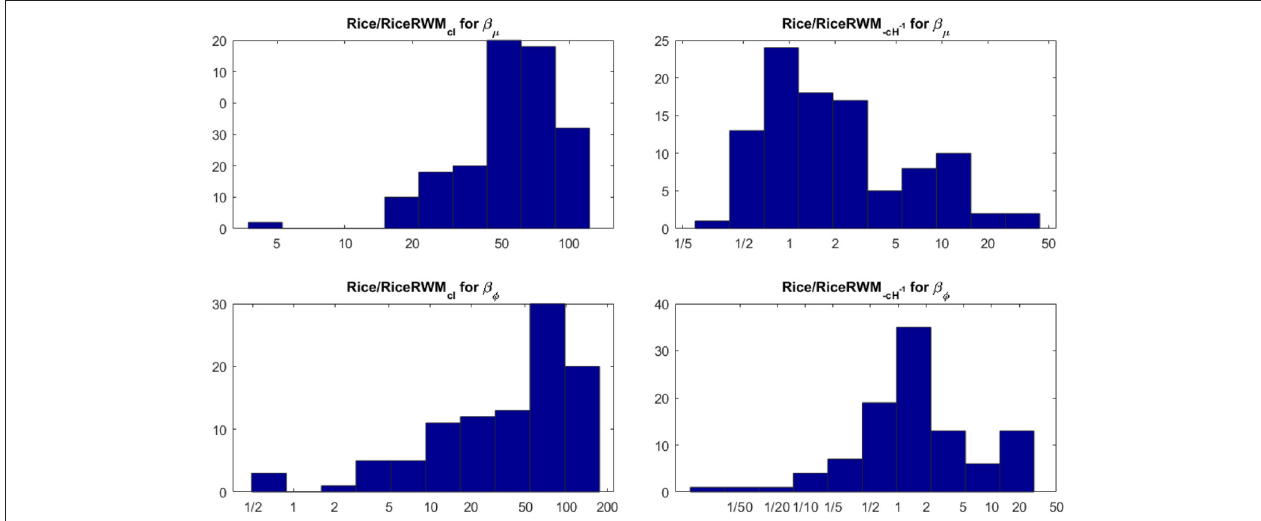
FIGURE 7 | Histograms of the ratio of independent draws per minute for our MCMC algorithm compared to each type of RWM algorithm for 100 randomly sampled white matter voxels for the Rician model. The number of independent MCMC draws is defined as the number of total MCMC draws divided by the estimated ∞ inefficiency factor IF = 1 + 2 k = 1 ρ k , where ρ k is the autocorrelation function of lag k of the MCMC chain. The rows correspond to the parameters, the columns to the two covariance matrices in the RWM P